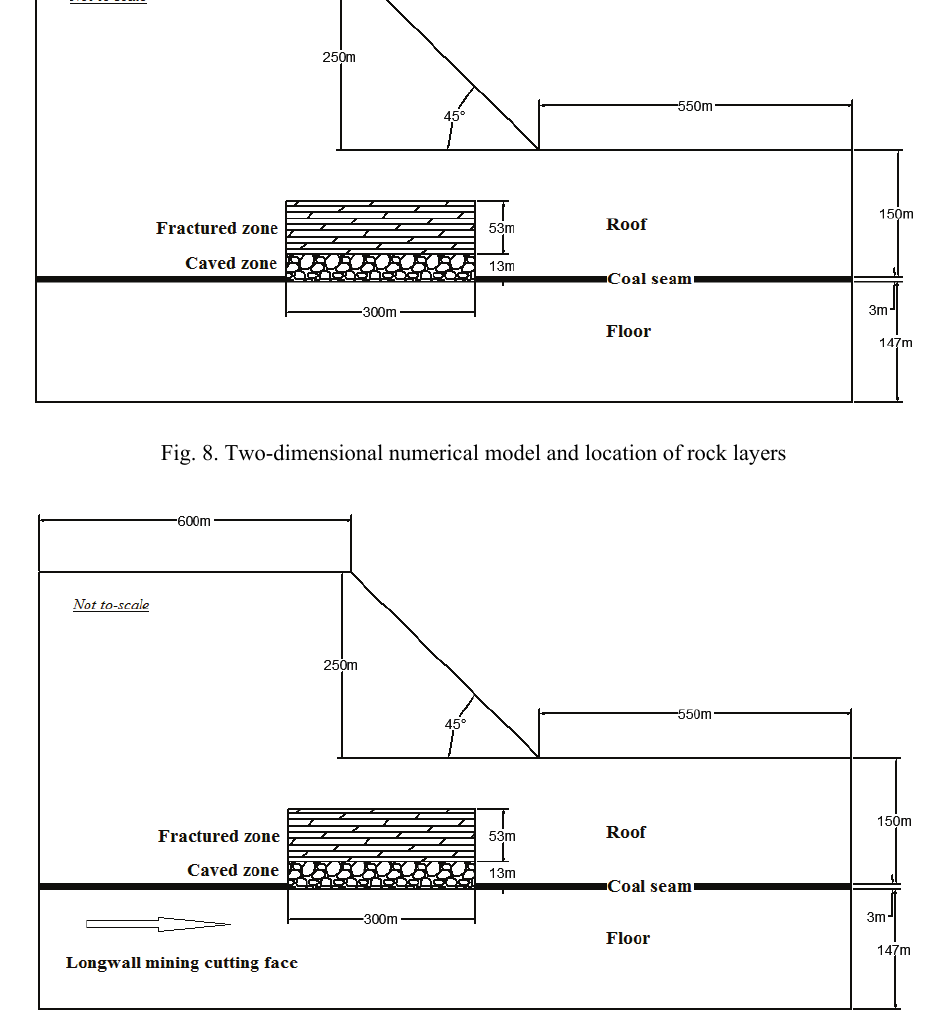
Fig. 9. Two-dimensional numerical model dal case study